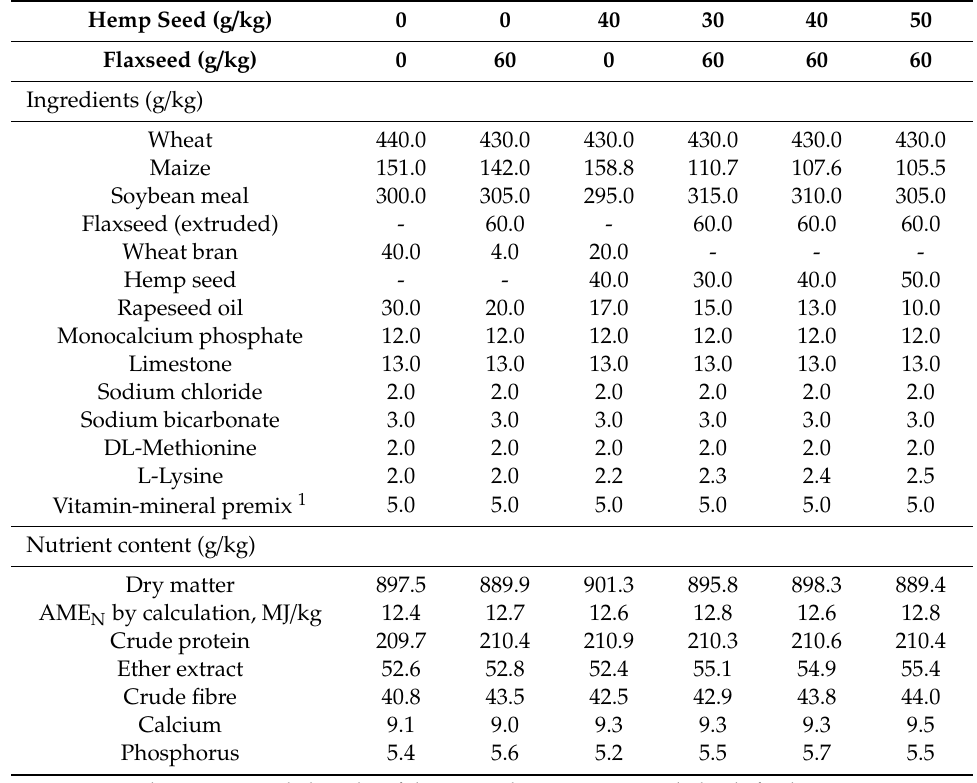
Table 2. Composition of broiler